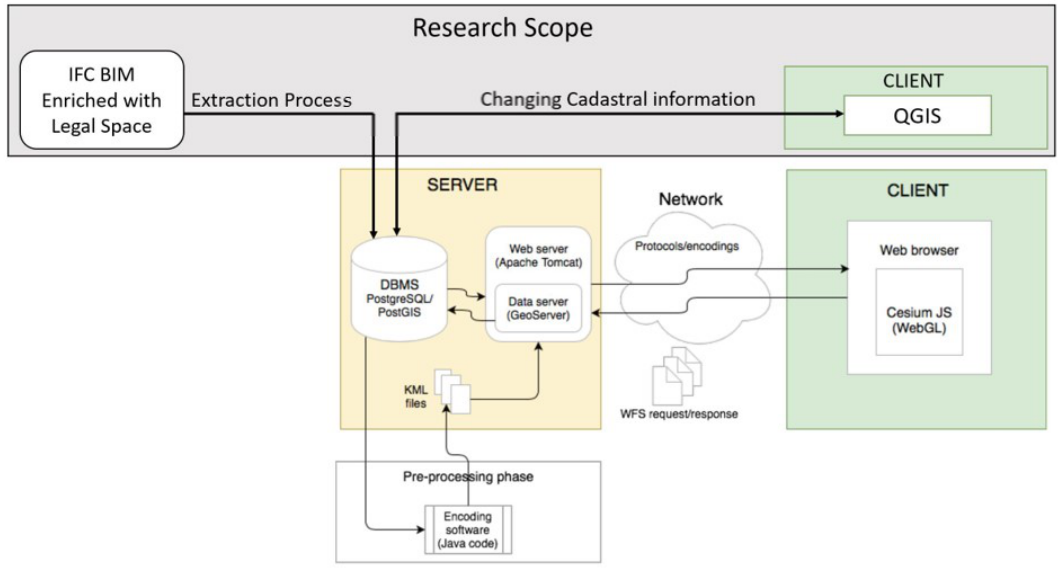
Figure 6. Architecture of the BIM-Legal prototype